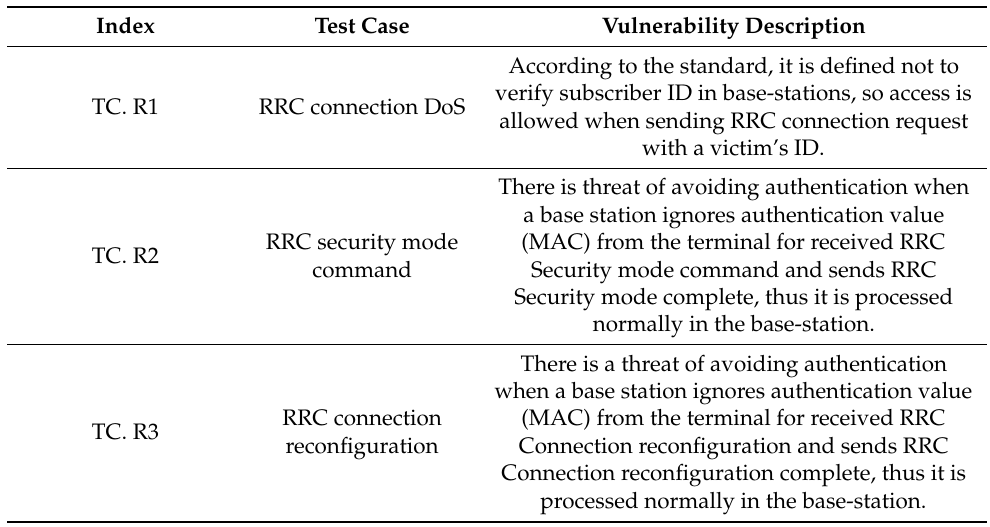
Table 3. RAN security threat test